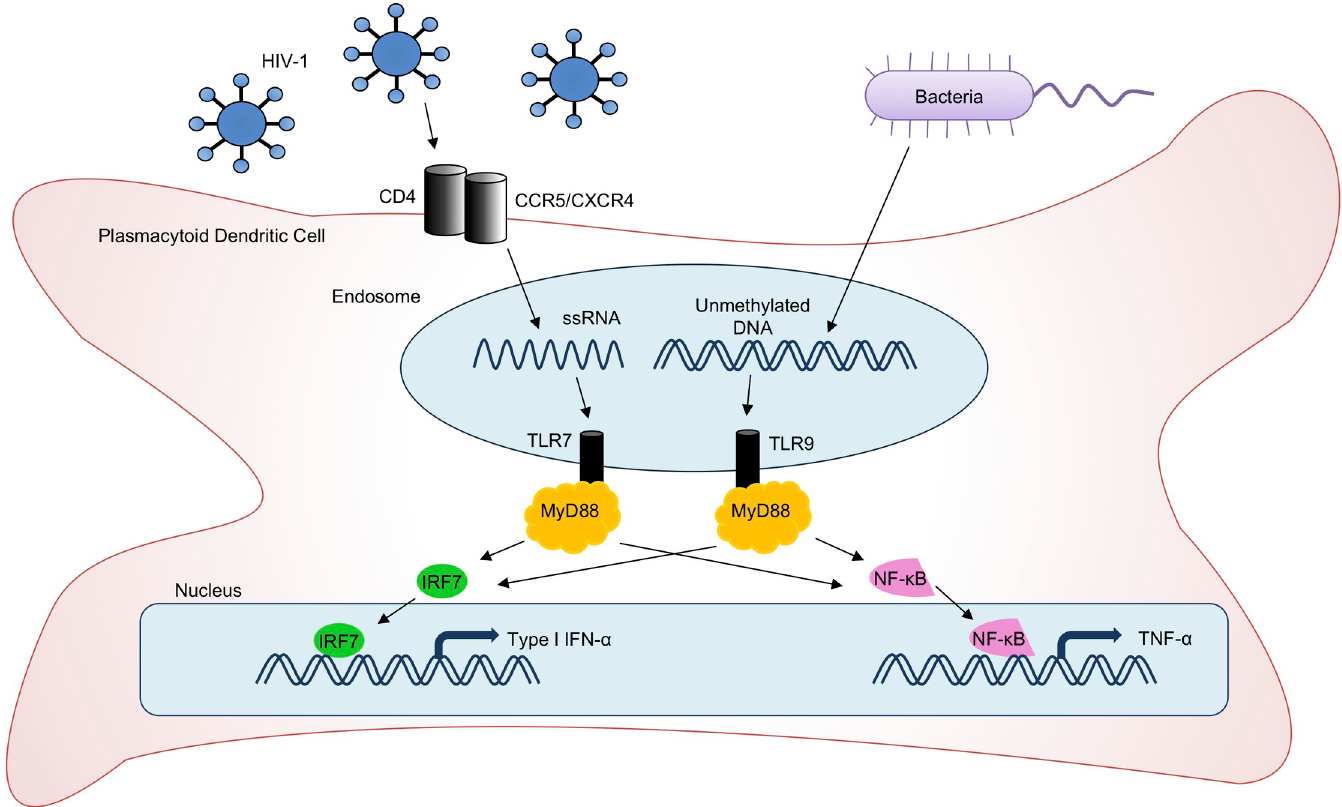
Fig 2. Signaling pathways of TLR7 and TLR9. Upon stimulation with viral RNA or unmethylated bacterial DNA, TLRs transduce signals that diverge below MyD88 to cause transcription of IFN- α or TNF- α .